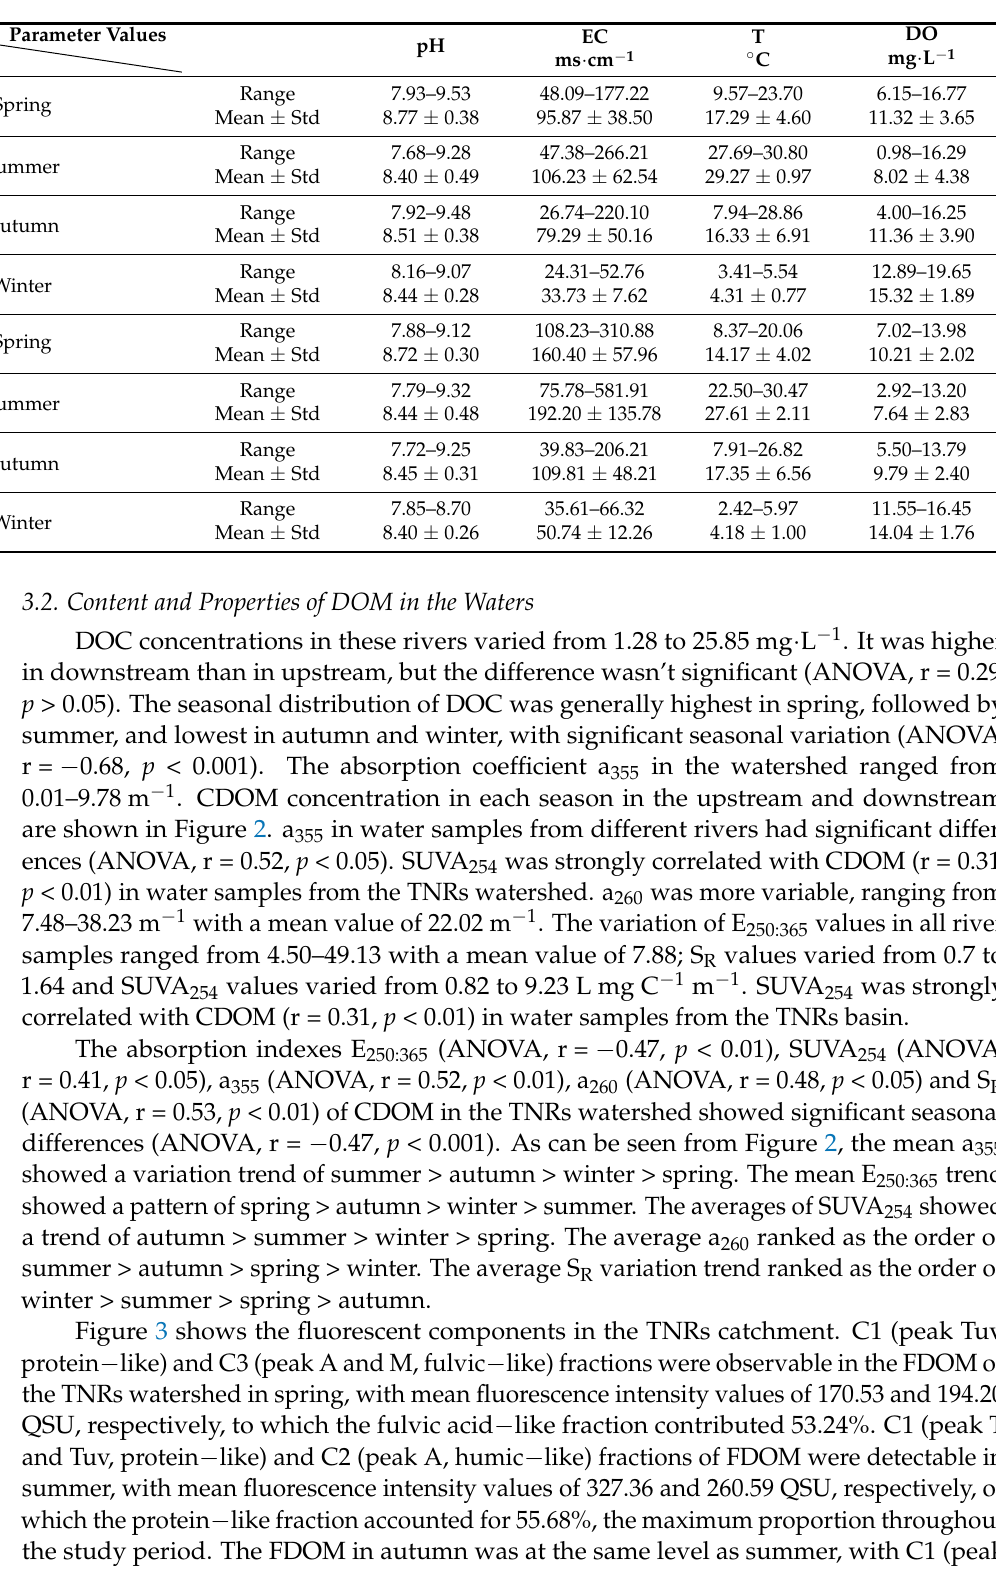
Table 1. Characteristics of water quality parameters in different seasons in the TNRs